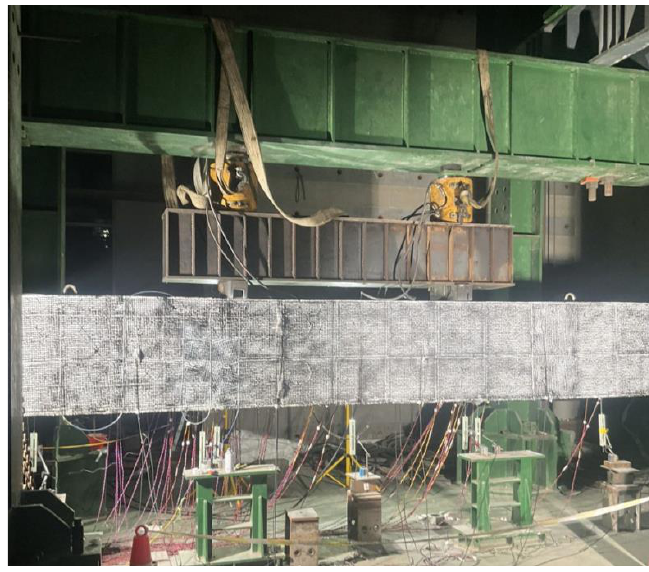
Figure 2. Laboratory test setup of precast segmental bent cap.